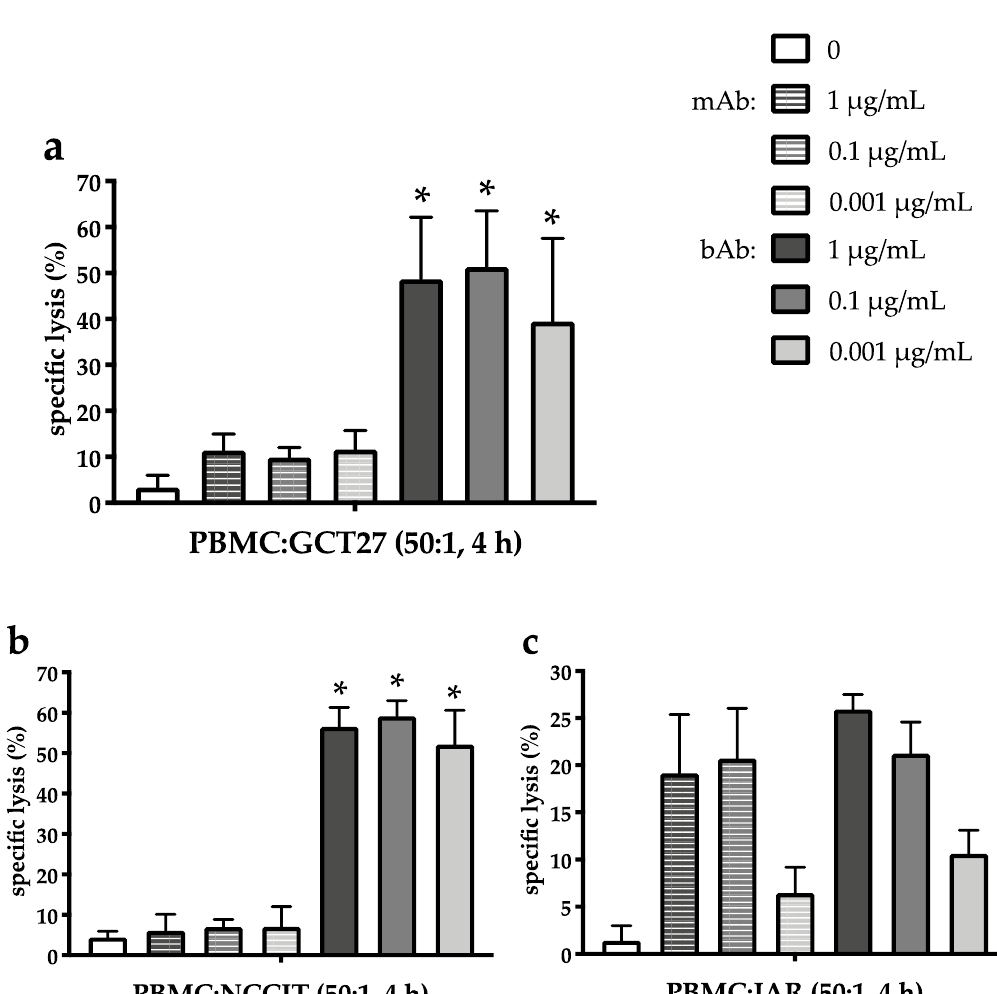
Figure 3. EpCAM/CD3-bispecific antibody exerts cytotoxic activity in different GCT cell lines independent of EpCAM expression and bAb concentration in the presence of PBMC. ( a ) GCT27, ( b ) NCCIT, and ( c ) JAR cells were incubated for 4 h with PBMC at an effector:target cell ratio of 50:1 and stated concentrations of the monoclonal EpCAM-Ab Vu1D9 (mAB) or the bispecific trifunctional EpCAM/CD3-Ab Catumaxomab (bAb). Antibody-dependent cytotoxicity was assessed by europium release assay in triplicates and expressed in percentage of dead cells. Data are presented as mean ± SD of two independent experiments. Statistically significant difference between mAb- and bAb-mediated cell death is marked by an asterisk (* p < 0.01).